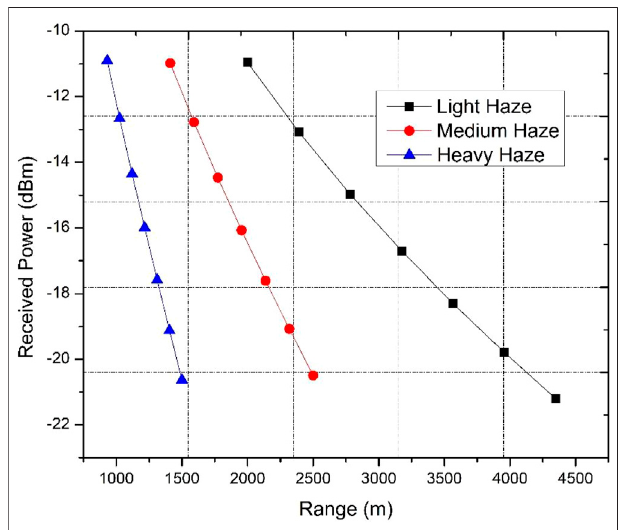
FIGURE 7 | Received power vs. range under different haze levels for OFDM/SAC-OCDMA-FSO.